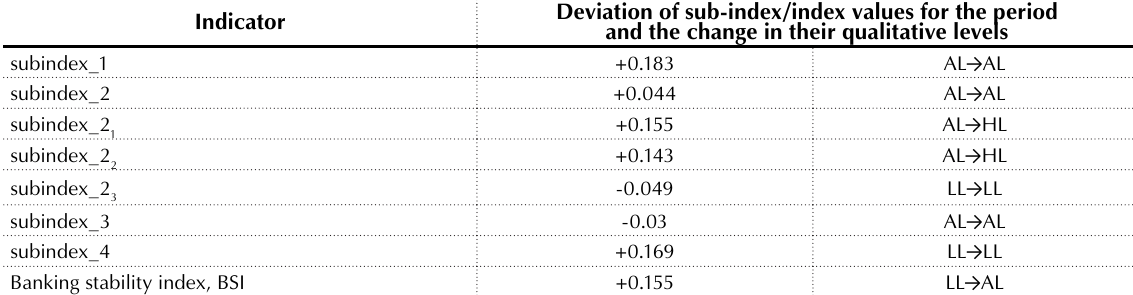
Table 1. Comparison of the assessment findings for banking system stability during the 2015–2016